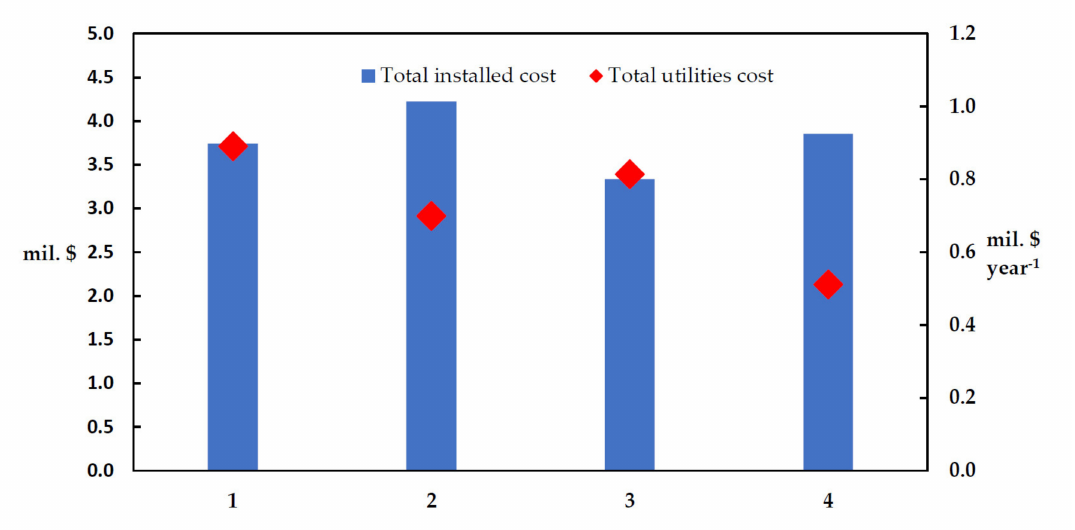
Figure 9. MVRHP effect on total equipment cost and total utility cost; 1—conventional process (Figure 2), 2—conventional process with an MVRHP (Figure 4), 3—RD column with a separation unit (Figure 3), 4—RD column with a separation unit and an MVRHP (Figure